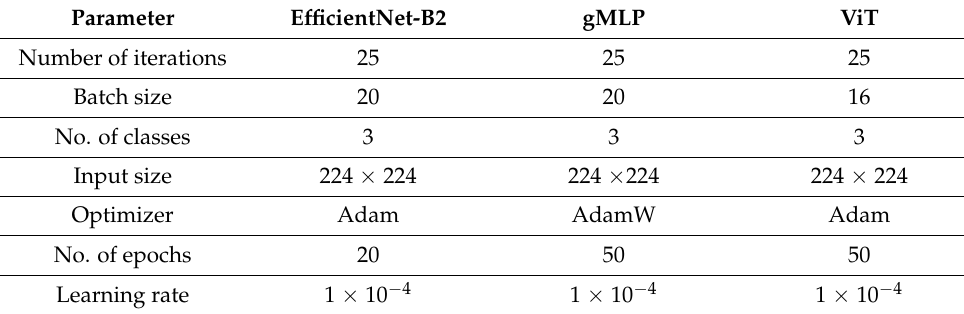
Table 2. Parameter optimization for EfficientNet-B2, gMLP, and ViT.